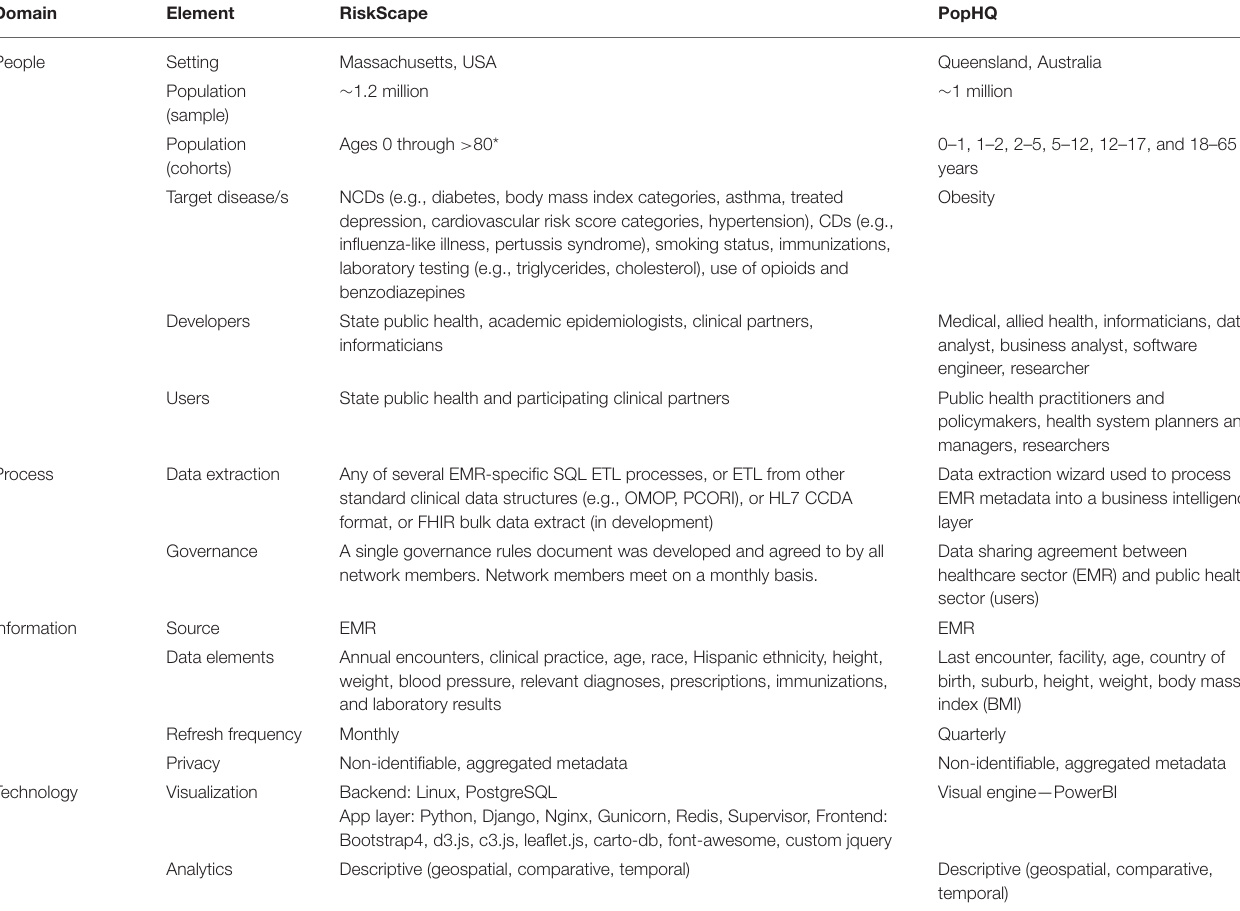
TABLE 1 | Key elements of two multinational use cases for precision public health of NCDs— RiskScape (USA) and PopHQ (Australia).